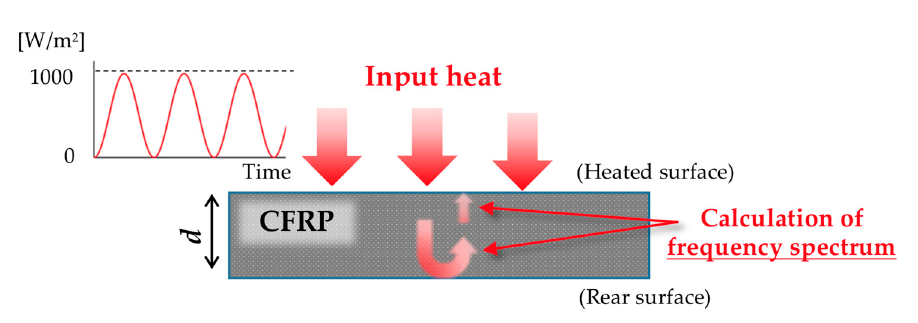
Figure 3. Schematic of numerical calculation to examine the frequency spectrum of thermal waves propagating in the CFRP